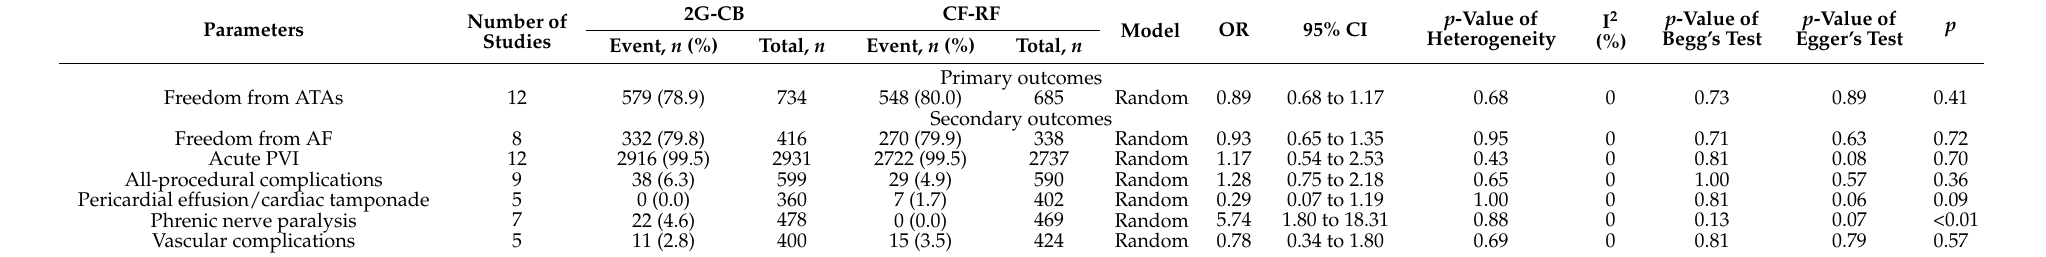
Table 3. Summary of the primary outcome and secondary outcomes.